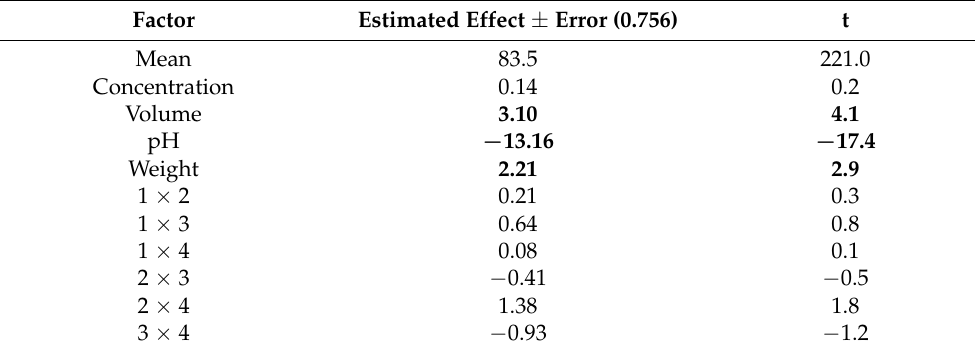
Table 4. Effects and errors of factors studied in a full 2 4 factorial design for mining.